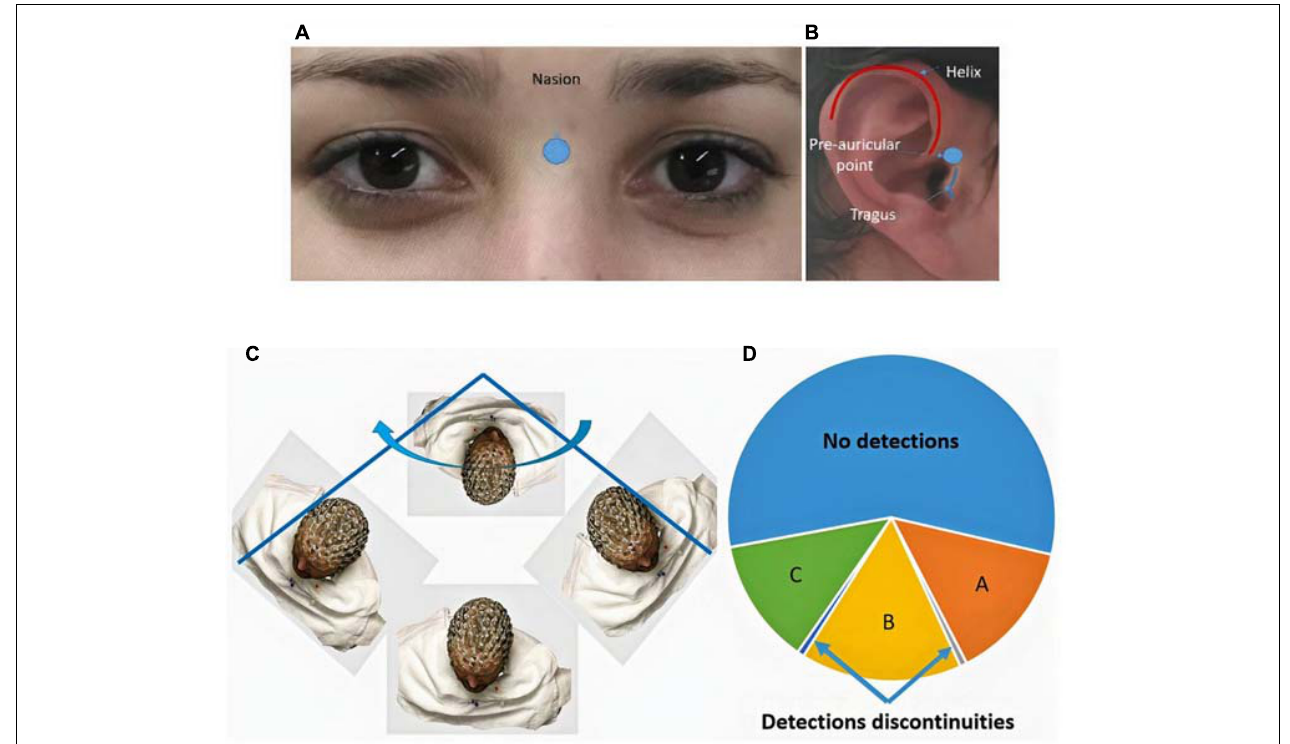
FIGURE 4 | (A) Nasion, (B) right preauricular point, (C) surface rotation for feature detection, and (D) detection of continuities and